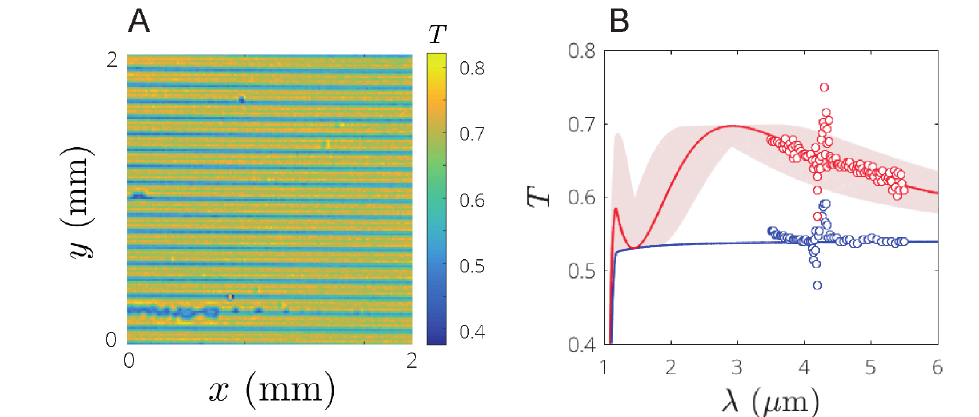
Figure 6. ( A ) Imaging the intensity transmission T at λ = 4 µ m for a micro-structured pattern. ( B ) Spectral transmission T in the mid-IR range. Symbols are the local average of the wavelength dependent transmittance for the bare silicon substrate (blue) and for the pattern (red, average along the bright lines). The solid blue line is the theoretical transmission of an incoherent silicon substrate; the solid red line corresponds to a calculated T with a coating thickness h = 400 nm, whereas the pale red zone shows the parametrization of T with h ranging from 300 to 600